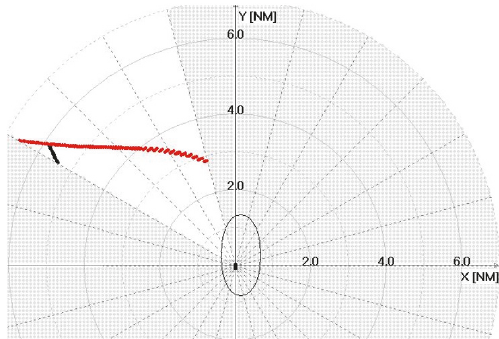
Figure 21: Action lines for stand-on crossing encounter with a target, whose true speed is 18 knots. Assumed are turns to starboard by 15 ∘ (red), 30 ∘ (blue), 45 ∘ (green), and 60 ∘ (black). No speed reduction.